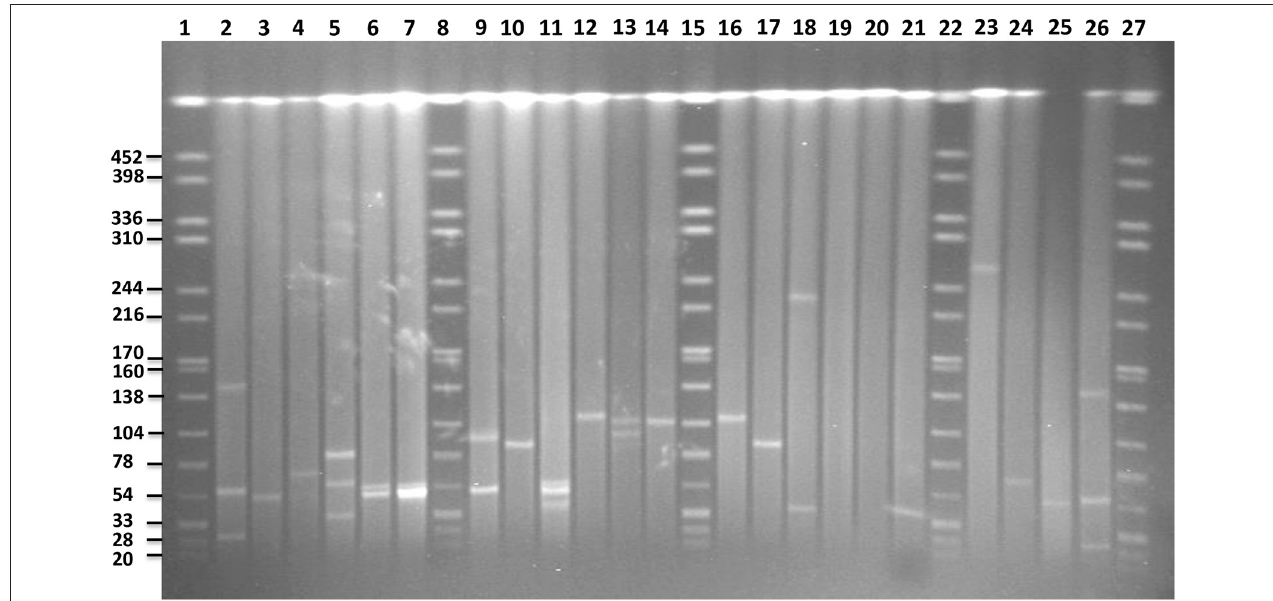
FIGURE 6 | PFGE gel of plasmid profiles in the examined Salmonella serovars. Lanes 1, 8, 15, 22, and 27 represent fragments generated by XbaI digestion of Salmonella Braenderup strain H9812. Fragment sizes are indicated on the left side of the gel. Lanes 2, 3, 4, 24, 25, and 26 represent plasmids of known sizes in Salmonella isolates from our own collection. Lanes 5, 6, 7, 9, 10, and 11 represent plasmids profiles of S. Enteritidis isolates 113, 15, 102, 14, 73, and 62, respectively. Lanes 12, 13, 14, 16, and 17 represent plasmid profiles of S. Typhimurium isolates 4233, 2256, 4829, B48, and 44, respectively. Lanes 18, 19 represent plasmid profiles of S. Virchow 590 and 645, respectively. Lanes 20, 21 and 23 represent plasmid profiles of S. Colindale 4770, S. Oakland 114, and S. Poona 323,